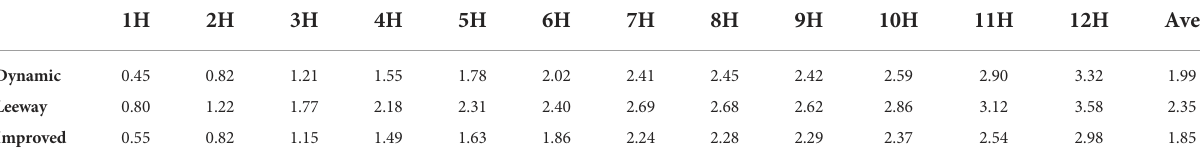
TABLE 8 The three simulated trajectories ’ average and hourly distance deviations (km) were calculated by the Lagrangian particle tracking method and the true trajectory of open lifeboat in Case 2.